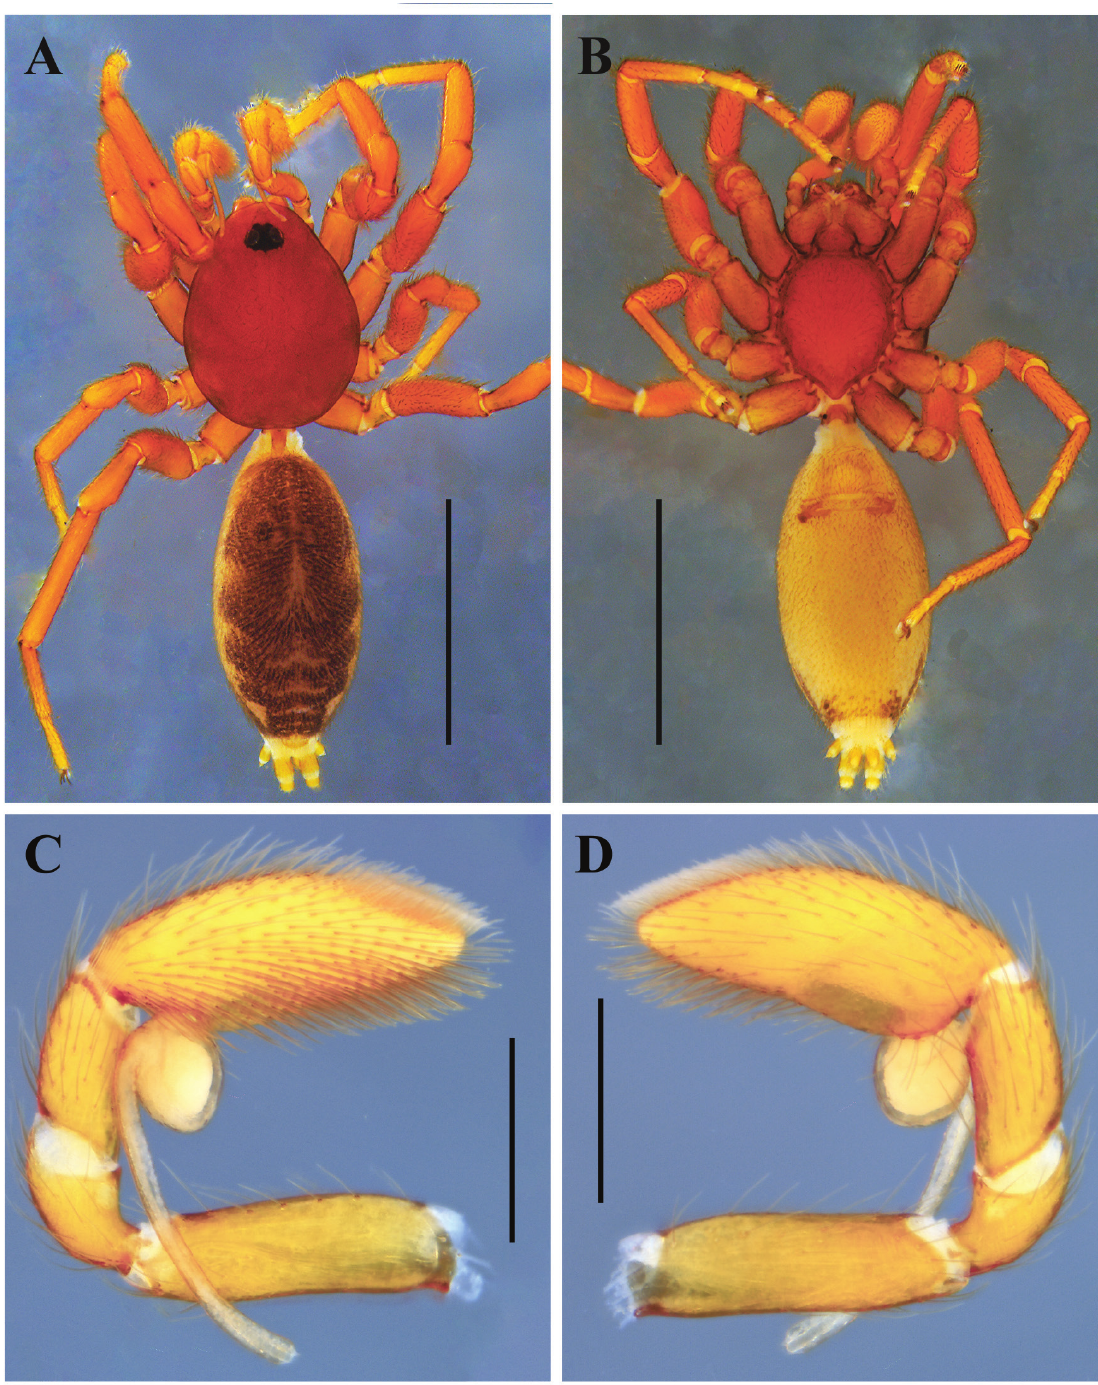
Fig. 5. Medionops santarosa sp. nov., holotype, ♂ (IAvH-I 3362). A . Habitus, dorsal view. B . Habitus, ventral view. C . Left palp, retrolateral view. D . Left palp, prolateral view. Scale bars: A–B = 1.5 mm; C–D = 0.5